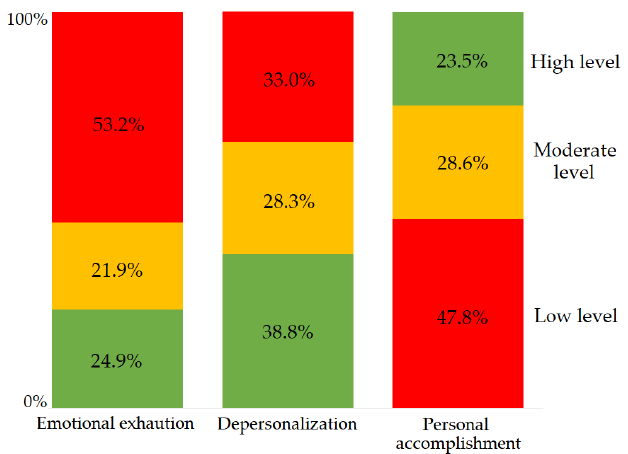
Figure 1. Distribution of achieved levels of burnout in all dimensions in the entire study sample (burnout depicted in red according to the above Data Analysis section). (burnout depicted in red according to the above Data Analysis